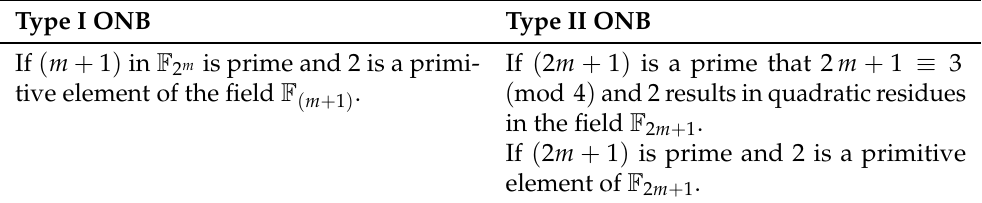
Table 1. Summary of the Optimal Normal Basis